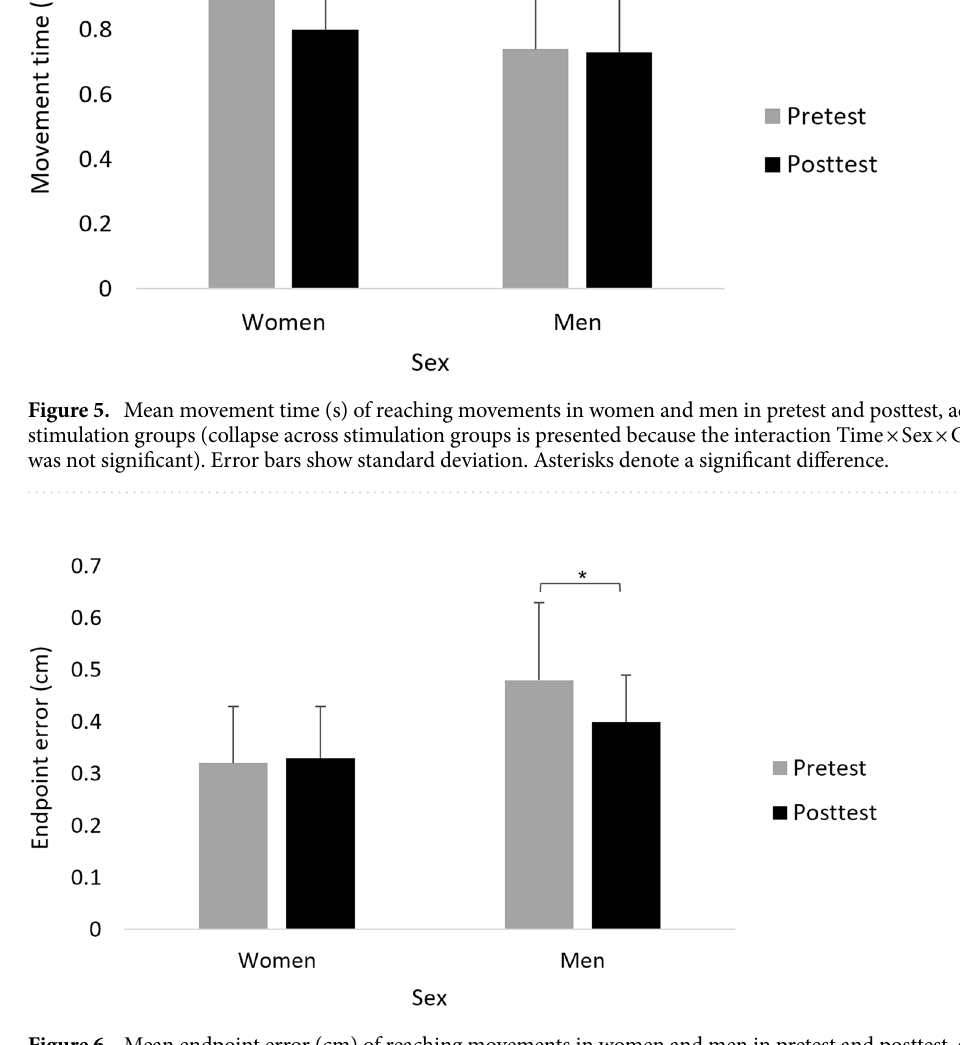
Figure 6. Mean endpoint error (cm) of reaching movements in women and men in pretest and posttest, across stimulation groups (collapse across stimulation groups is presented because the interaction Time × Sex × Group was not significant). Error bars show standard deviation. Asterisks denote a significant difference.